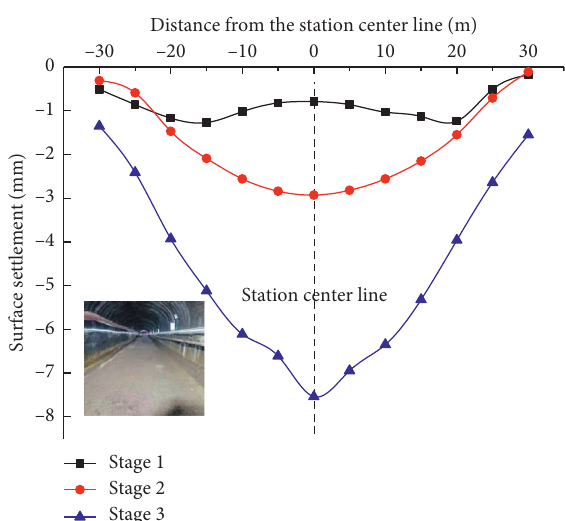
Figure 4: Surface settlement curves during the construction of pilot tunnels.